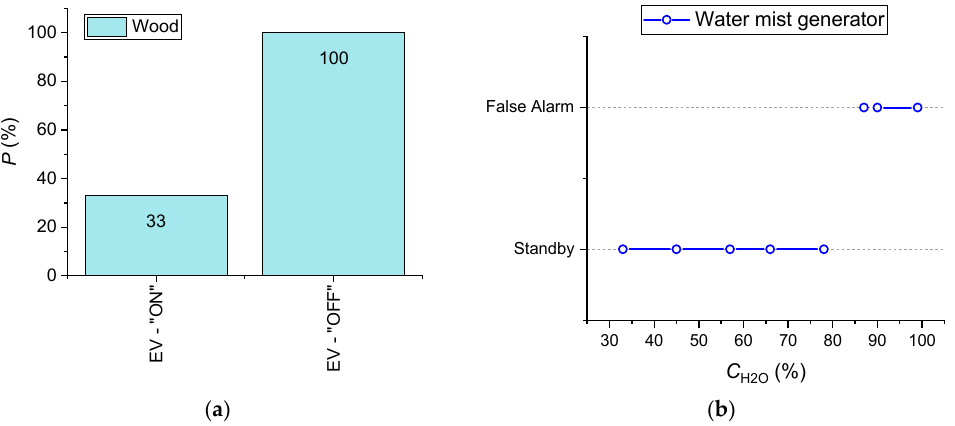
Figure 20. Average SD activation times during the combustion of wood for the two schemes under consideration: ( a ) Scheme #1; ( b ) Scheme #2.